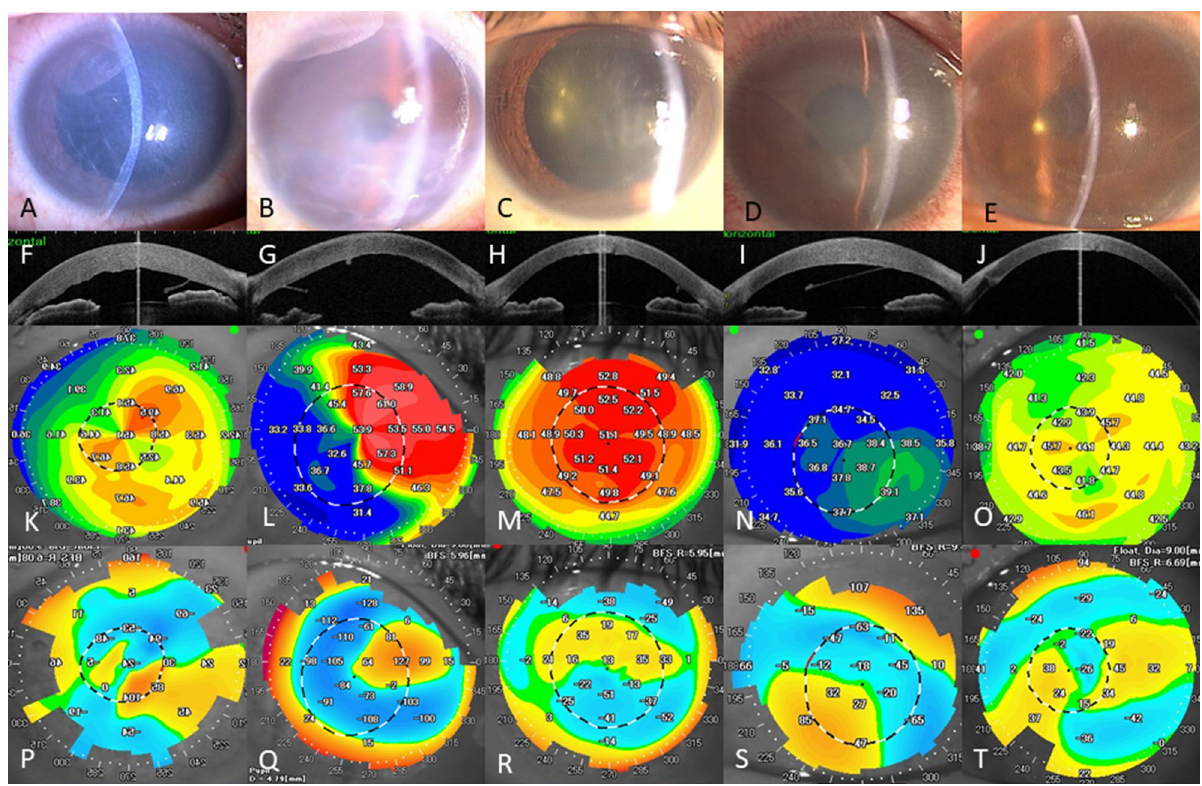
Figure 2. Representative cases of forceps injuries. Representative slit-lamp photographs ( A – E ), AS-OCT images ( F – J ), and topographic maps of the anterior ( K – O ) and posterior surfaces ( P – T ) of eyes with bullous keratopathy due to forceps corneal injuries. Topographic maps are characterized into five patterns: regular astigmatism ( A , F , K and P ), asymmetry ( B , G , L , and Q ), protrusion ( C , H , M , and R ), flat ( D , I , N , and S ), and posterior irregular patterns ( E , J , O , and T ).